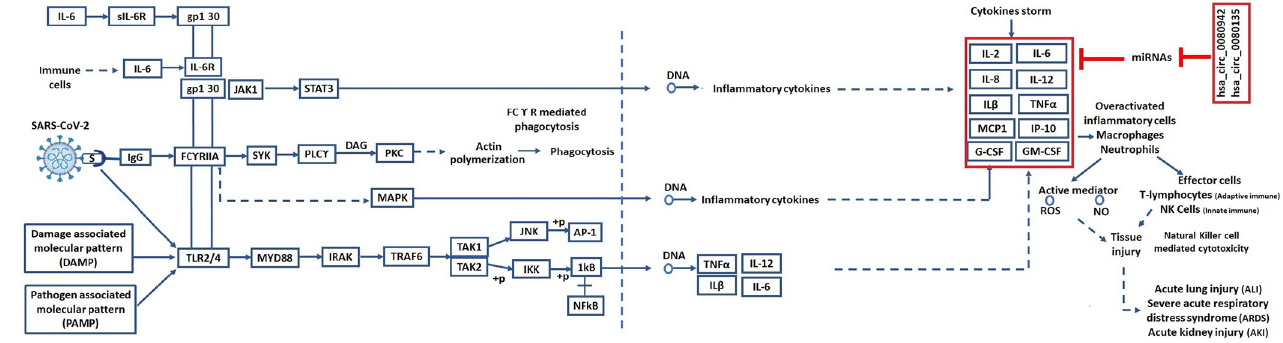
Fig 7. Pathway analysis of COVID-19 pathogenesis (KEGG pathway ID: map05171). Highlighted genes are targets of miRNAs and indirect targets of two prioritized circRNAs.